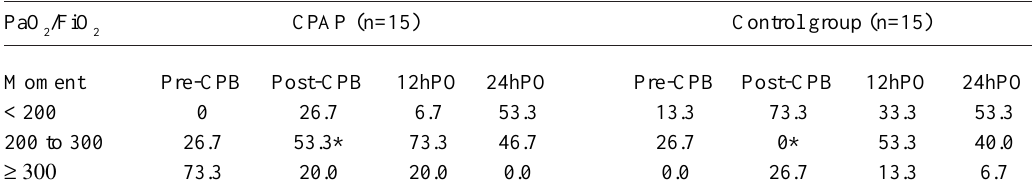
Table 4. Distribution of patients (%) according to categorical values of PaO moments in CPAP and control groups.